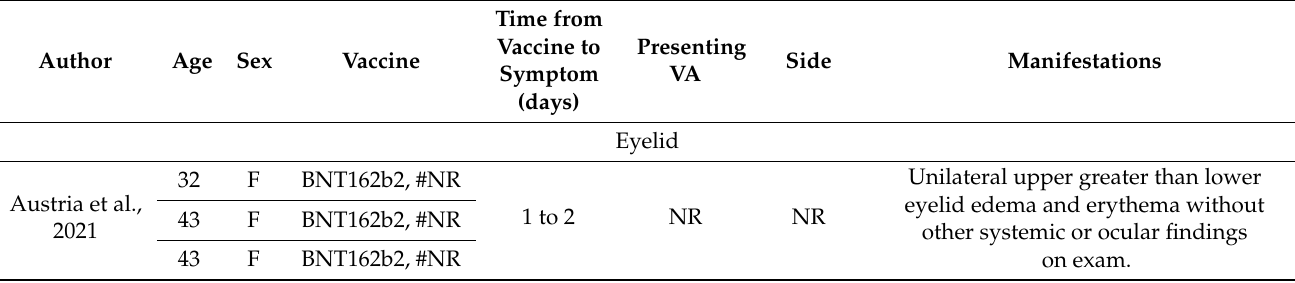
Table 1. Aggregated information on reviewed